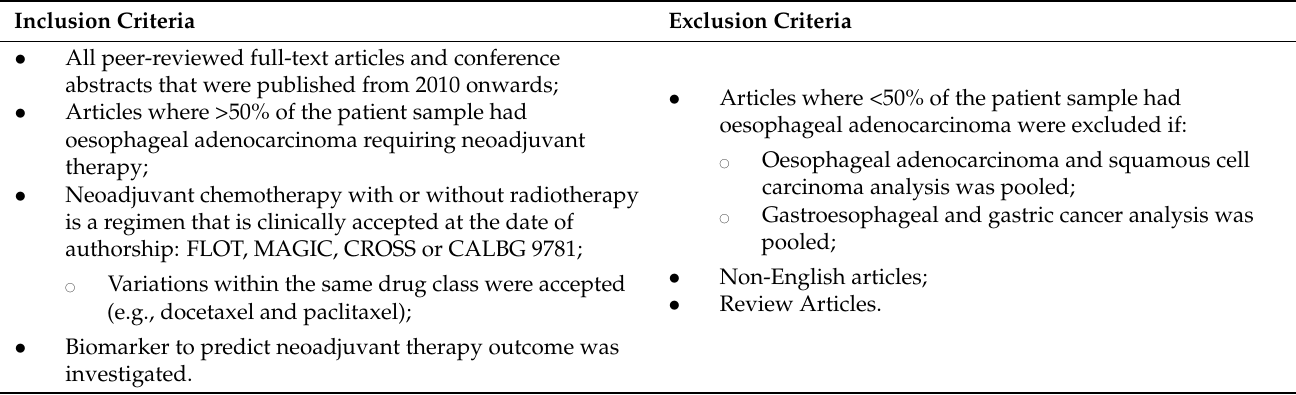
Table A9. Inclusion and exclusion criteria.